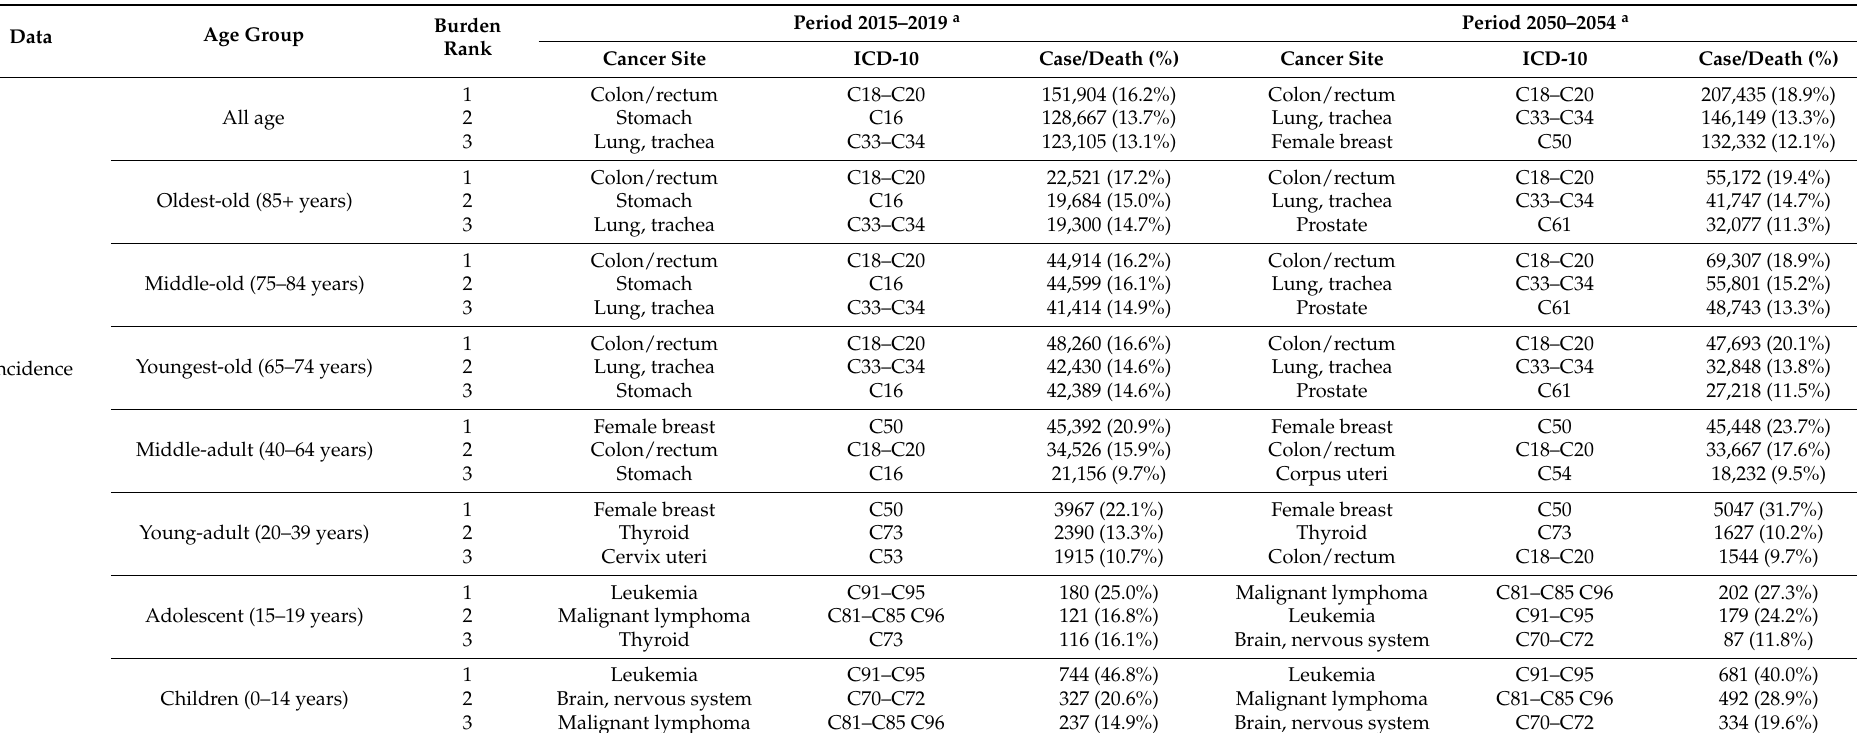
Table 3. Top three cancer diagnoses in 2015–2019 and 2050–2054 by age group (both